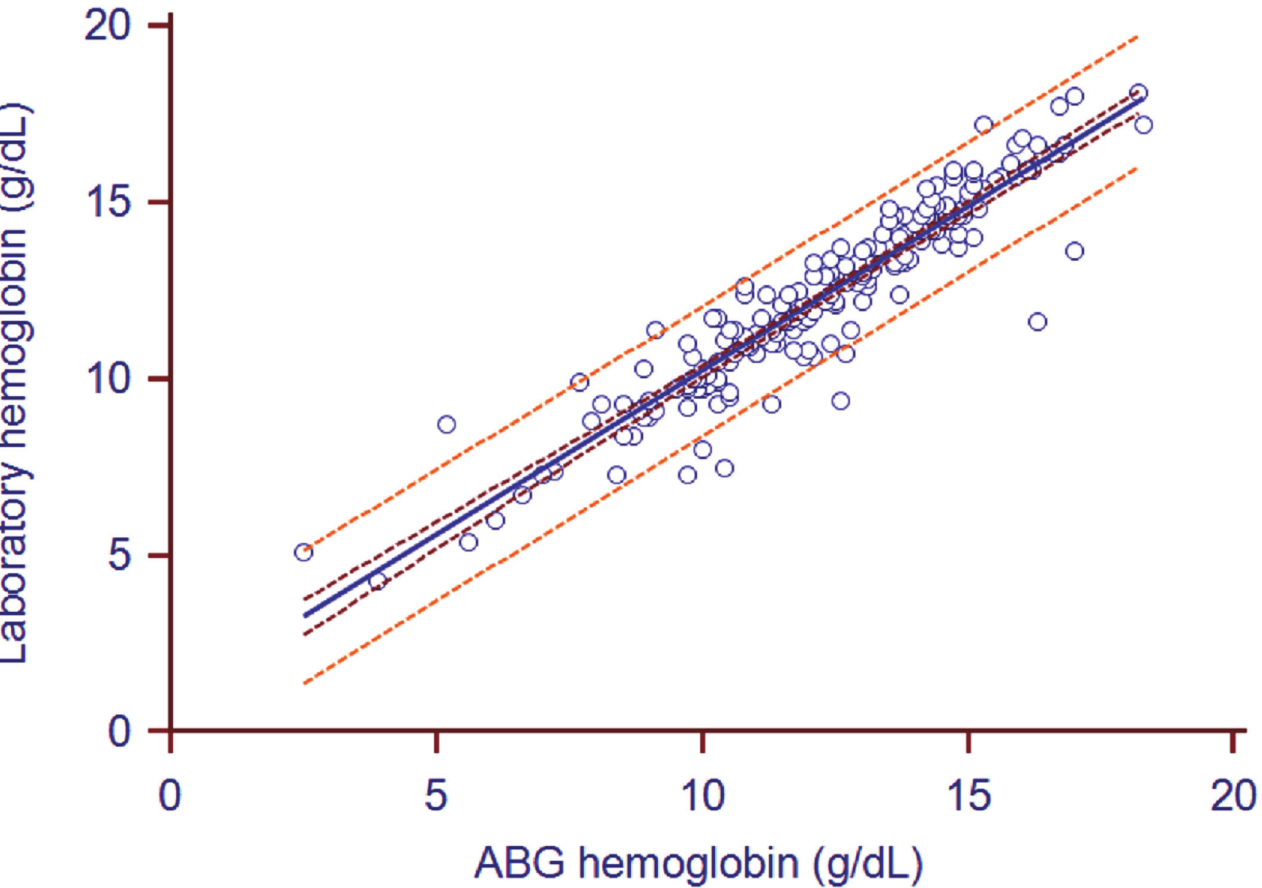
Fig 6. Hemoglobin scatter plot with Deming fit. Concordance plot shows agreement between laboratory- and ABG-measured hemoglobin (in g/dL). The solid line indicates the correlation coefficient (r = 0.94). The brown line indicates the 95%CI of correlation coefficient (0.92 to 0.95). The orange line indicates the